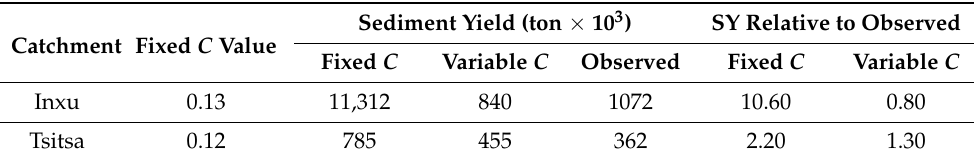
Table 4. Summary of sediment yield (SY) output in the Inxu and Tsitsa catchments compared to observed data.